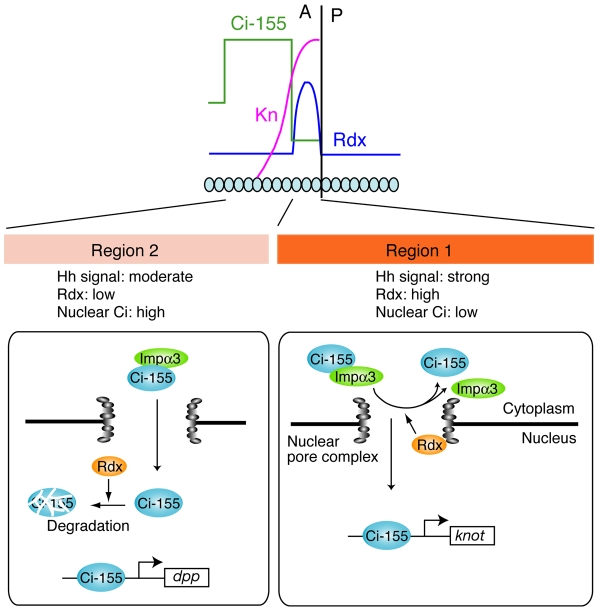
Model for the switching of the dual function of Rdx depending on Hh signal strength.In region 1 abutting the A/P boundary, which receives strong Hh signal, the Rdx levels are high. In this region, Rdx inhibits the nuclear import of Ci-155 by competing with importin α3 for binding to Ci-155 at the nuclear pore complex. This maintains the nuclear Ci-155 at low levels. Low levels of nuclear Ci-155 selectively activate the transcription of kn. Low levels of nuclear Ci-155 may be central to the selective induction of specific Hh target genes, such as kn. On the other hand, in region 2 distant from the A/P boundary, which exhibits moderate levels of Hh signal, the Rdx levels are moderate. In this region, the nuclear import of Ci-155 is allowded, which maintains the nuclear Ci-155 at relatively high levels; however, the nuclear Ci-155 level is negatively regulated by Rdx via a proteasome-dependent degradation. The relationship between Hh signal, Rdx and Ci is shown below. Strong Hh signal induces Rdx expression, which inhibits the nuclear entry of Ci-155.